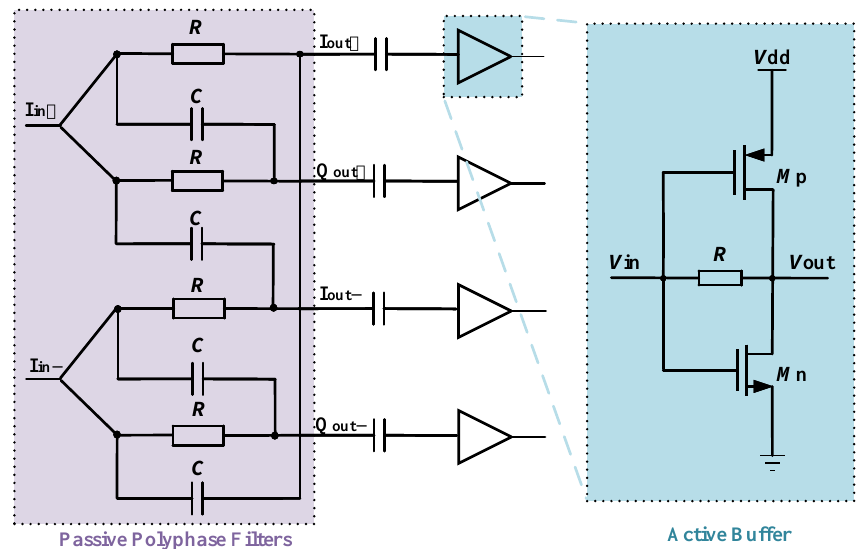
Figure 3. Schematic diagram of passive polyphase filter and active